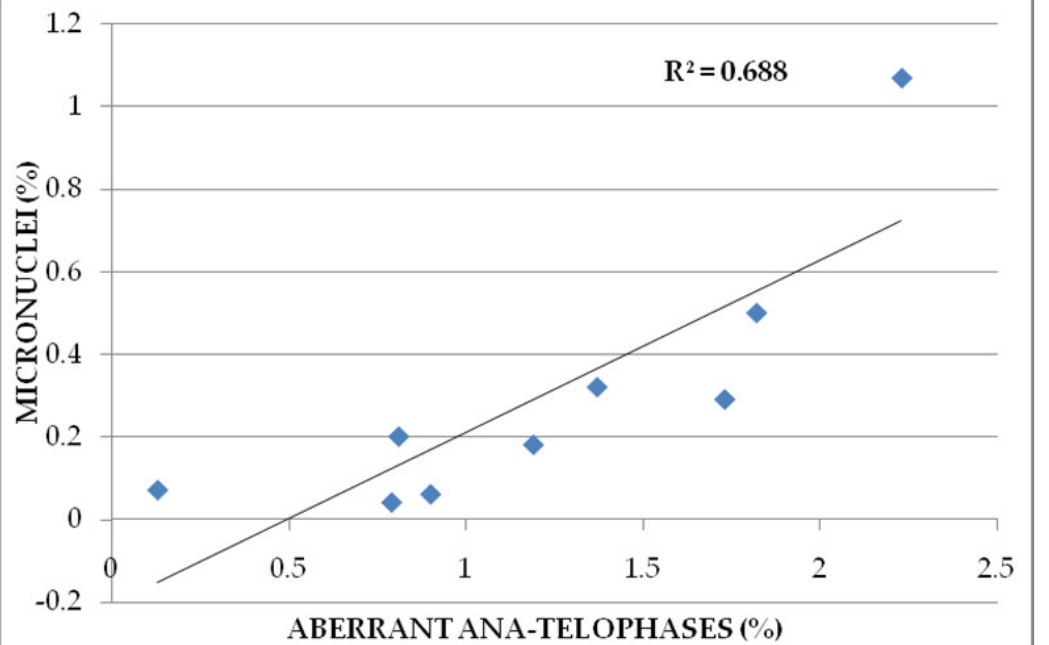
Figure 6. Correlation between aberrant A-T and micronuclei in wheat root meristem cells treated with Merlot and Sauvignon blanc grape marc extracts.